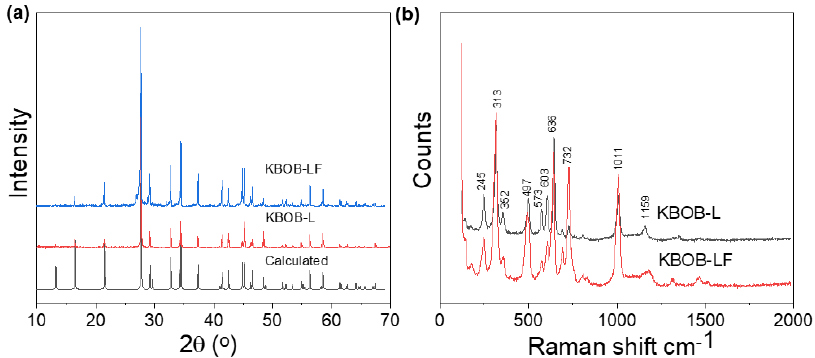
Figure 2. ( a ) The XRD patterns and ( b ) the Raman spectra of KBOB-L and KBOB-LF crystals, respec- tively.